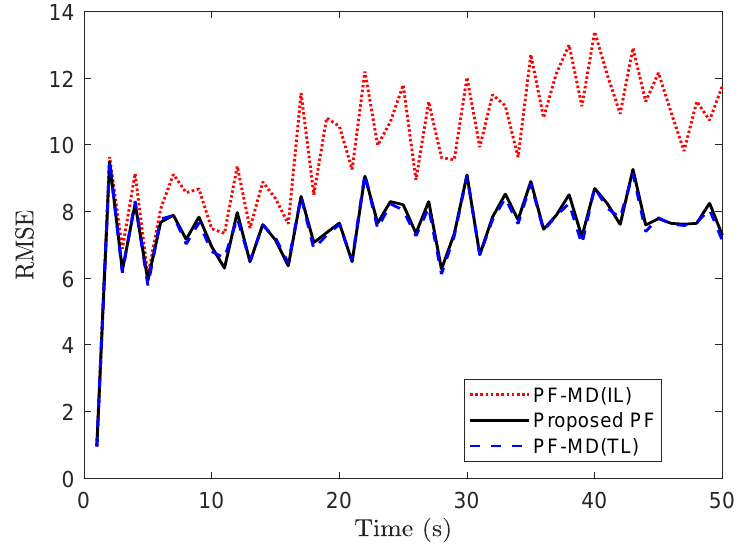
Figure 5. RMSE of different filters for measurements with no packet drops considering p = 0.50 (problem 1).